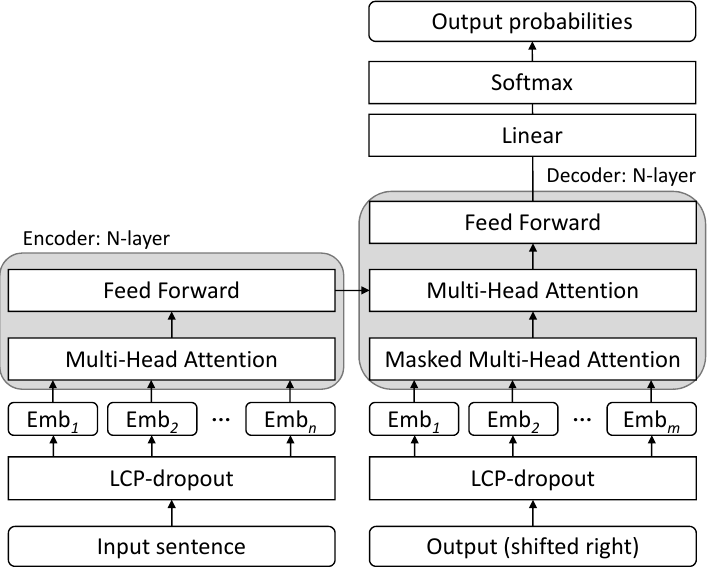
Figure 1. Framework of our neural machine translation model with